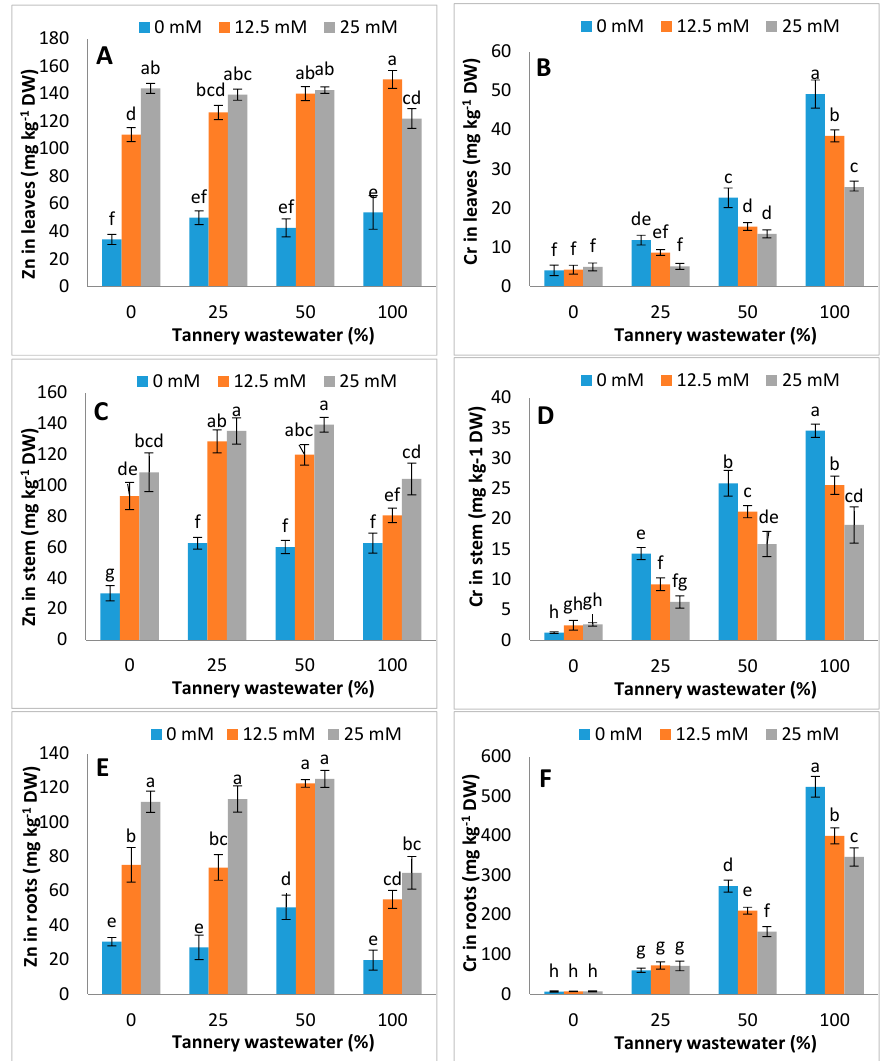
Figure 7. Graphs showing effect of foliar spray of zinc chelated lysine (0, 12.5, 25 mM) on Cr and Zn concentration in leaves ( A , B ), stem ( C , D ) and roots ( E , F ) of maize plants growing under 0%, 25%, 50%, 100% concentration of tannery wastewater. Values are means of three replicates. Statistical analyses were carried out by ANOVA, followed by Tukey’s Post-Hoc